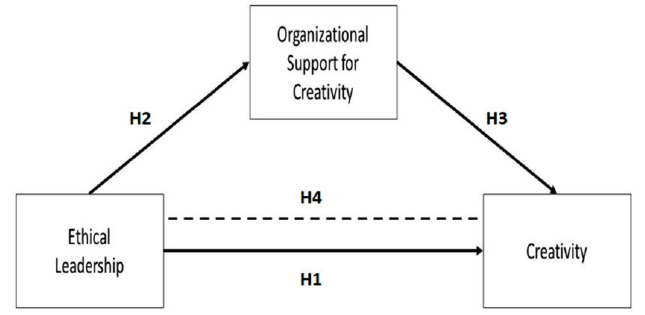
Figure 1. Proposed study model (source: created by